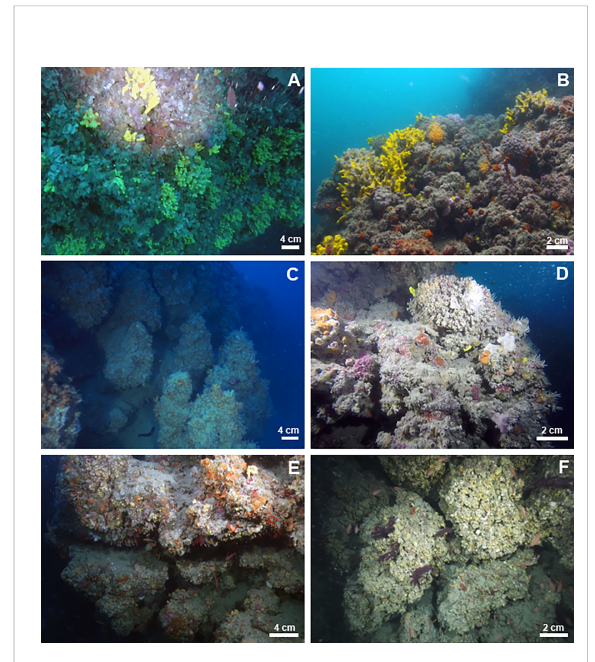
FIGURE 2 Underwater images of the morphological features of studied mesophotic bioconstructions: (A) TRM, (B) MON, (C) CAP, (D) SFC, (E) OTR, and (F)